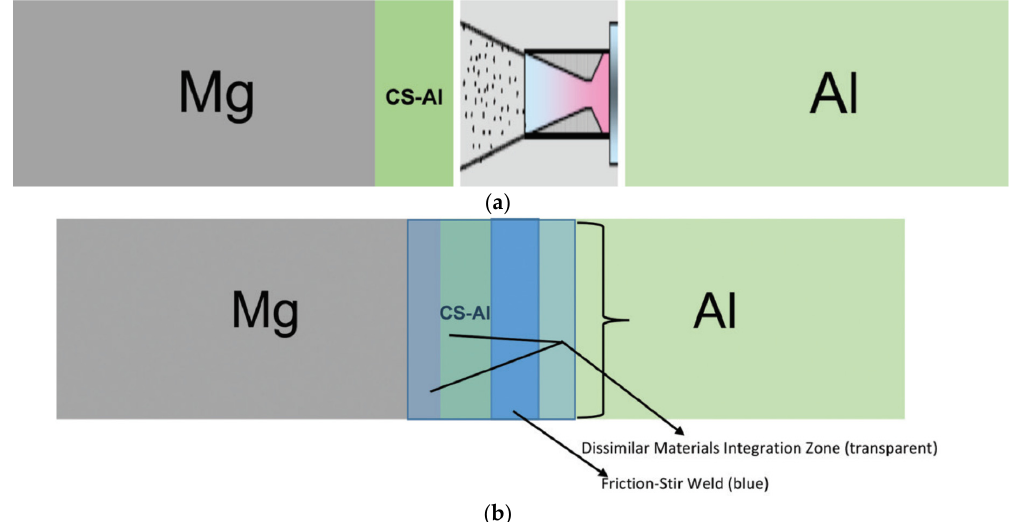
Figure 23. Schematic of ( a ) cold sprayed 6061 Al to the edge of the ZE41A Mg (buttering the edge) and ( b ) use of friction stir welding (FSW) to join the ZE41A Mg to 6061 Al [70].